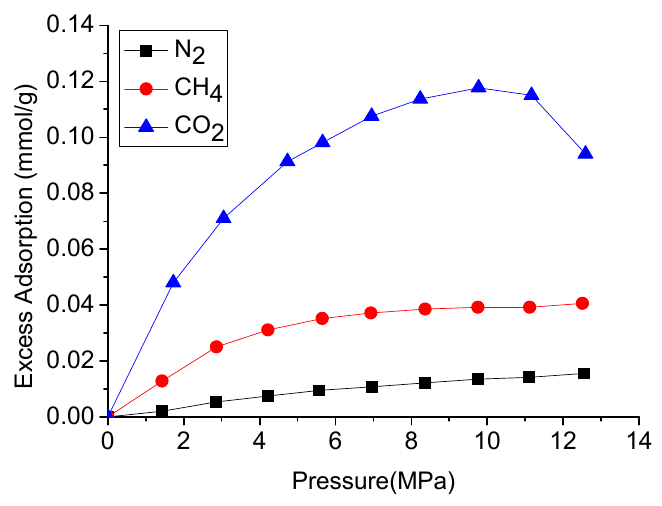
Figure 15. Excess adsorption of different gases on New Albany shale [37].